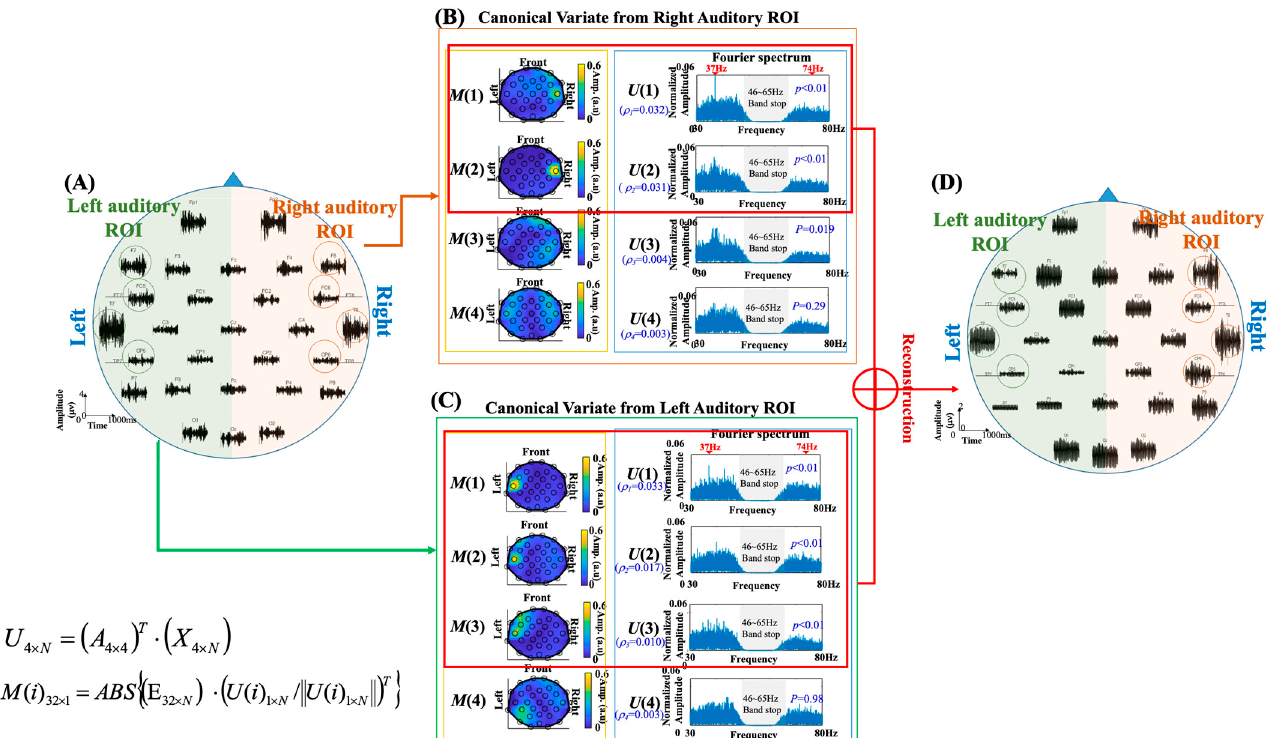
Figure 1. The demonstration of CCA for ASSR extraction in subject5: ( A ) The left panel shows the channel plot of the recorded EEG signals. ( B ) The spatial maps and Fourier spectra of canonical vectors by setting the COI located in the vicinity of the right auditory cortex. ( C ) The spatial maps and Fourier spectra of canonical vectors by setting the COI located in the vicinity of the left auditory cortex. ( D ) The channel plot of the ASSR signals were reconstructed from ASSR-related canonical vectors.